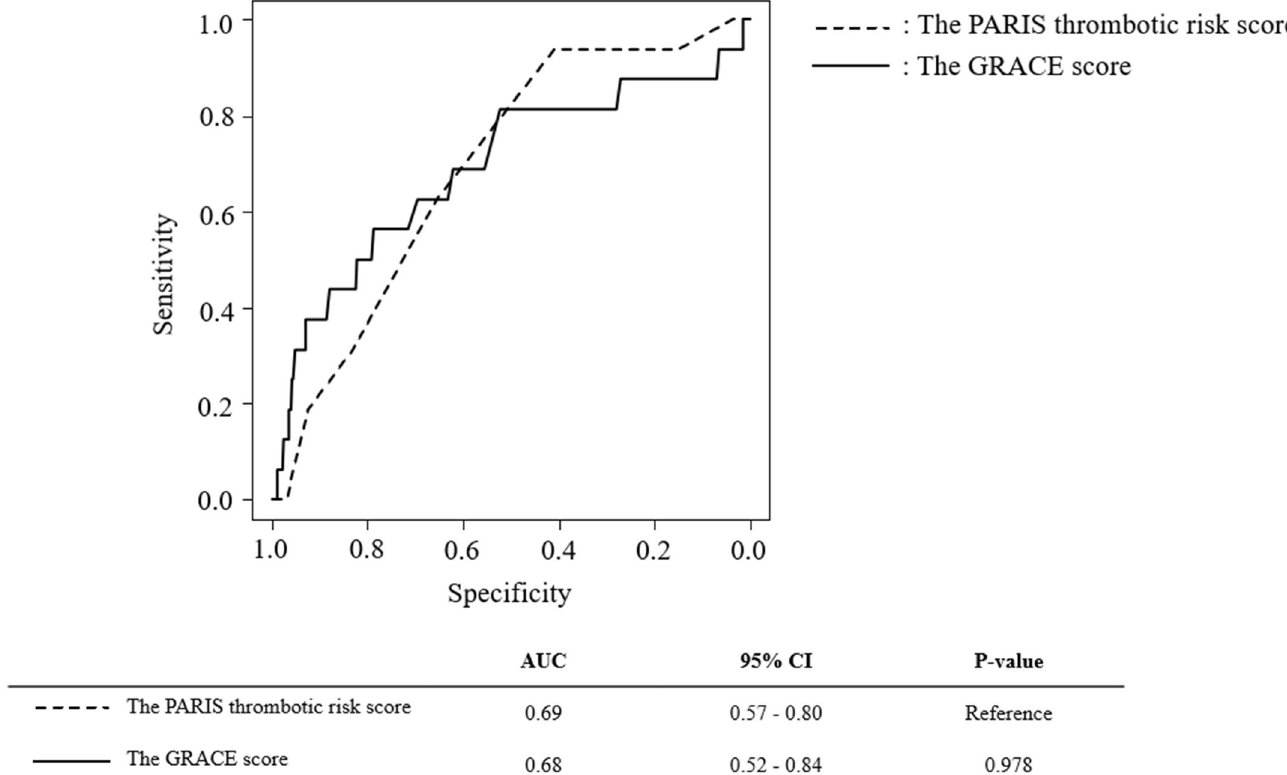
Fig 4. Receiving operating curves (ROC) to predict mortality in 6 months in patients with acute coronary syndrome. PARIS, the Patterns of non-Adherence to anti-platelet Regimen in Stented patient; GRACE, Global Registry of Acute Coronary Events; AUC, area under the curve; CI, confidence